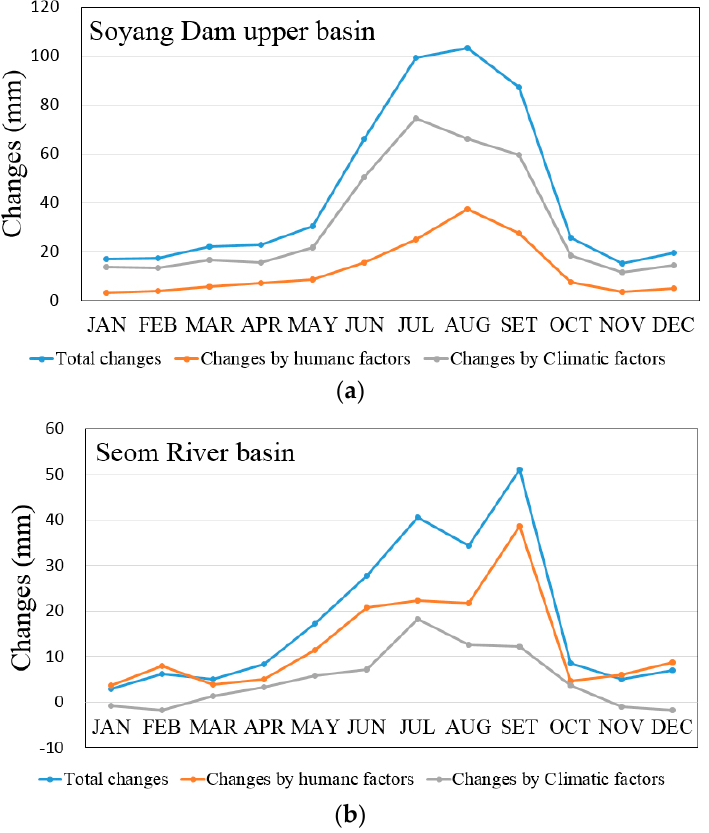
Figure 8. Estimated monthly changes. ( a ) Soyang Dam upper basin; ( b ) Seom River basin.